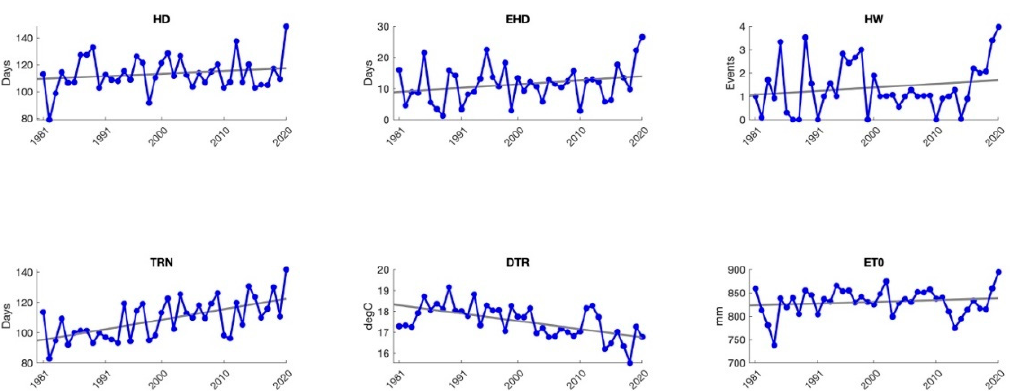
Figure A6. Annual agroclimate metrics averaged over the Coachella Valley region with linear trendline. Metrics are shown as: row 1: growing degree days (GDD), chill portions (CP), frost days (FD); row 2: last spring freeze (LSF), first fall freeze (FFF), frost-free season (FFS); row 3: heat days (HD), extreme heat days (EHD), heatwaves (HW); row 4: tropical nights (TRN), diurnal temperature range (DTR), summer reference evapotranspiration (ETo). GDD, TRN, and DTR have statistically significant trends over the 40-year period.